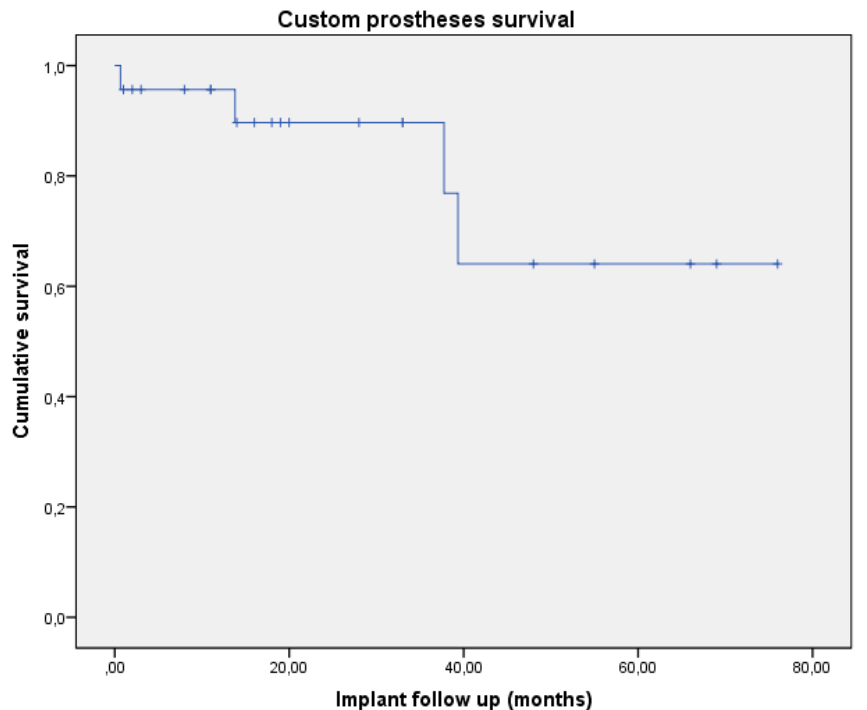
Figure 2. Custom prostheses specific survival. Five years implant specific survival of 64%.